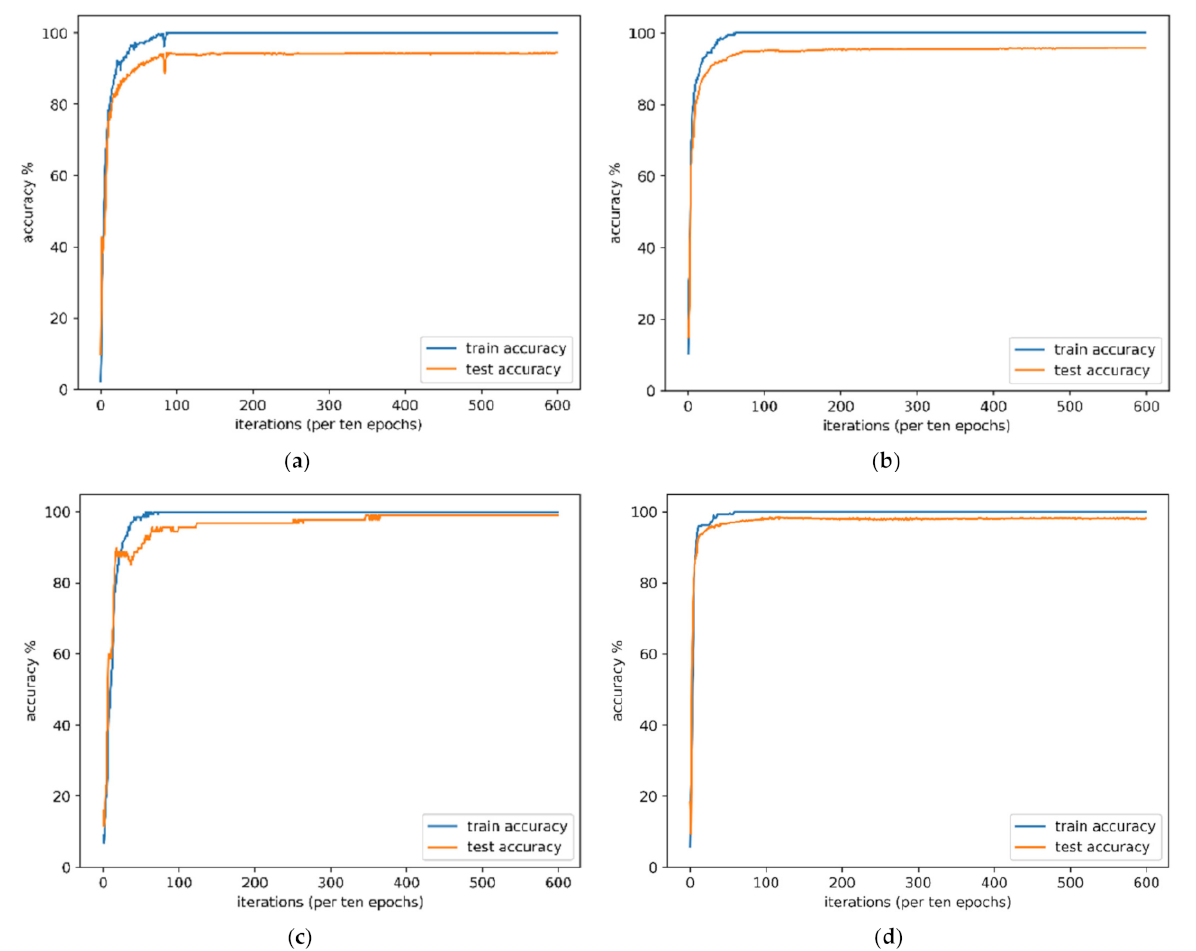
Figure 15. Training Convergence Plots of MFEGCN-FSAM; ( a ) Indian Pines; ( b ) University of Pavia; ( c ) Kennedy Space Center; ( d )